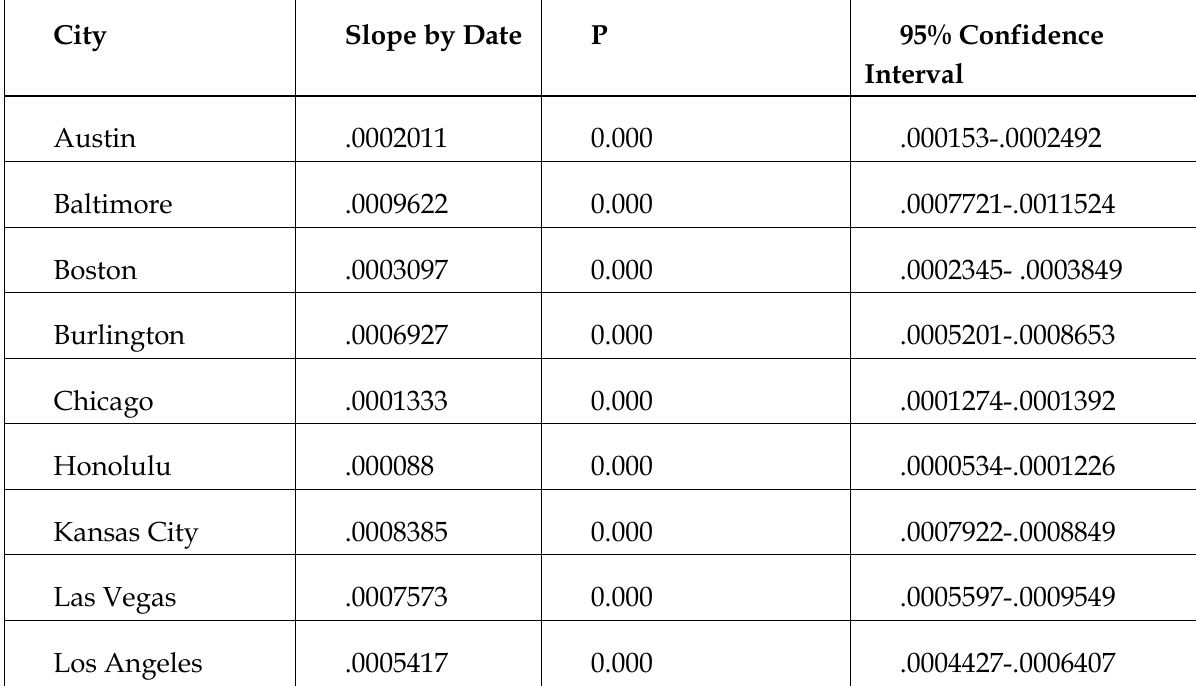
Table 4: The OGD Heartbeat Trajectory 5 City Slope by Date P 95%